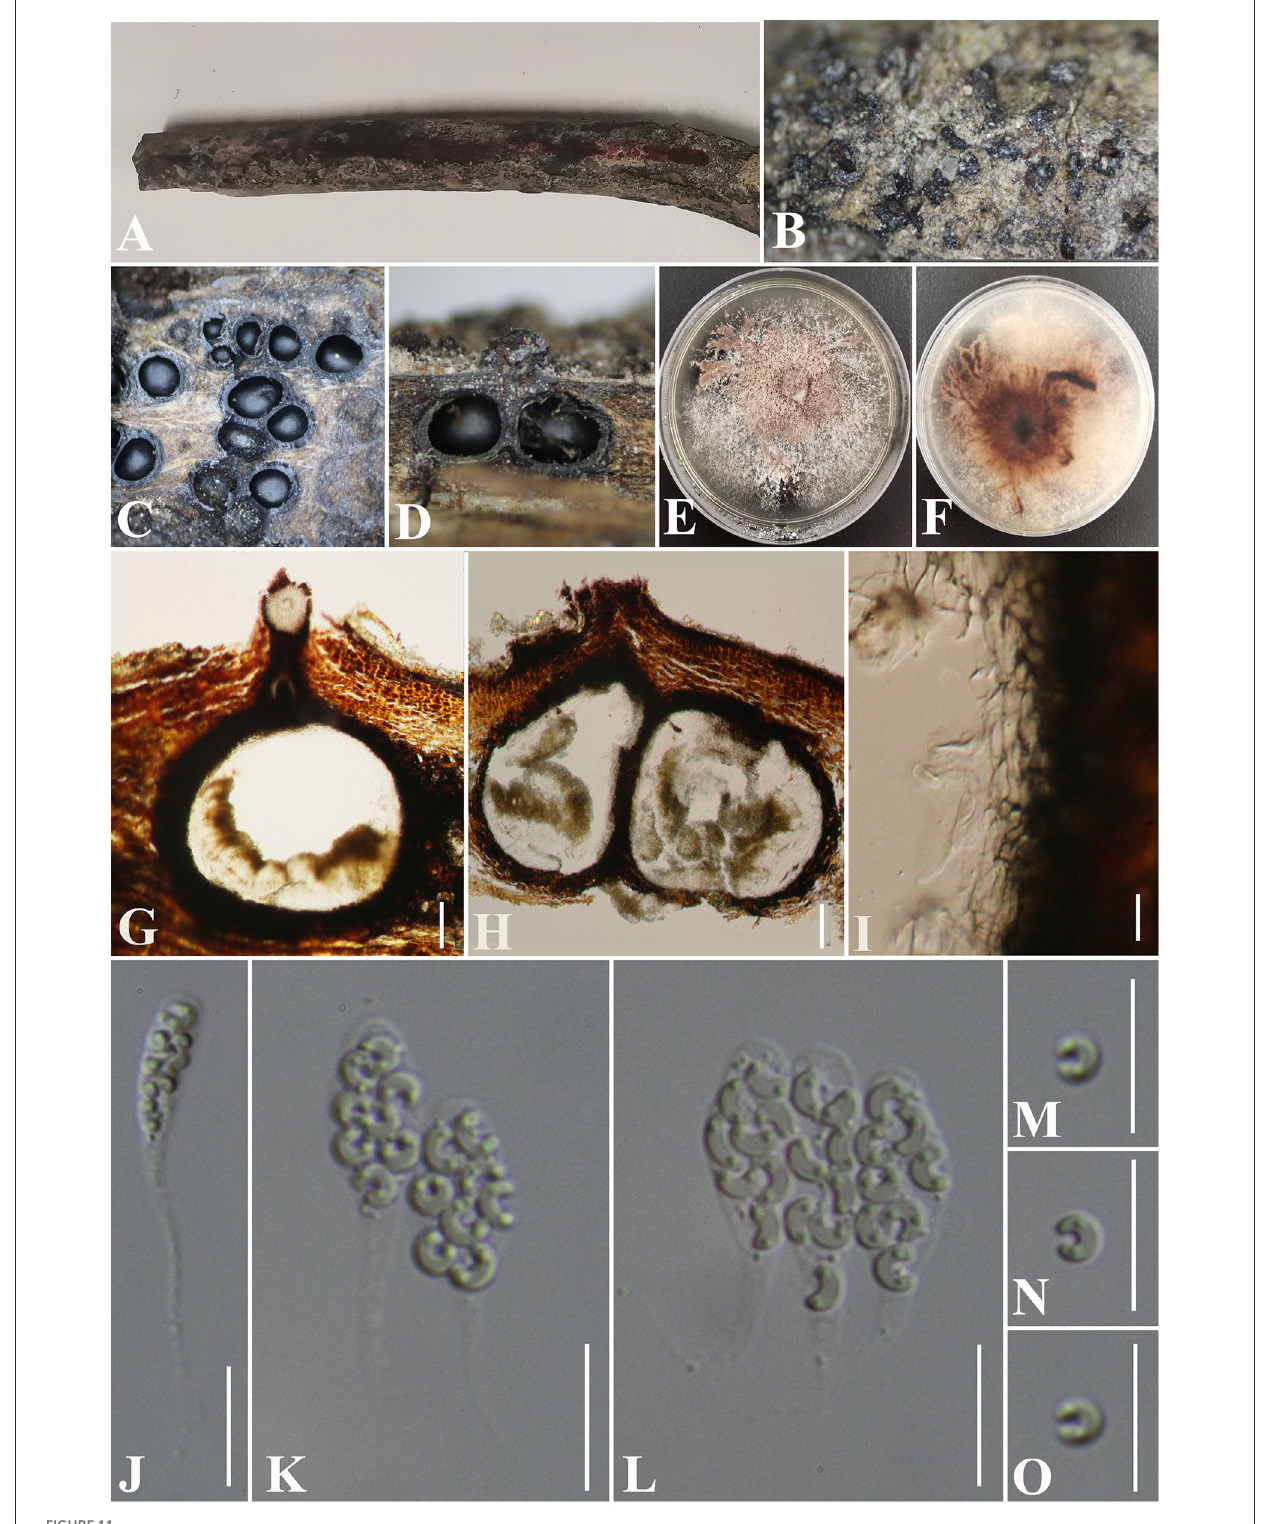
FIGURE11 Peroeutypa hainanensis (GMB0424, holotype). (A) Type material. (B) . Close-up of stromata. (C) Transverse section through stromata. (D) Vertical section through stromata. (E, F) Culture on PDA. (G, H) Sections through the ascostroma. (I) Peridium. (J–L) Asci. (M–O) Ascospores Bar: (G, H) = 100 µ m; (I–O) = 10 µ